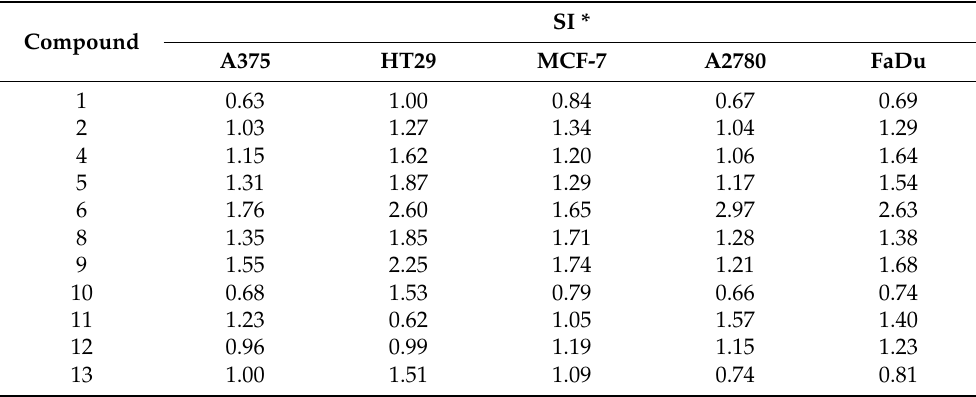
Table 2. Selectivity * of compounds 1 , 2 , 4 – 6 , 8 – 20 .